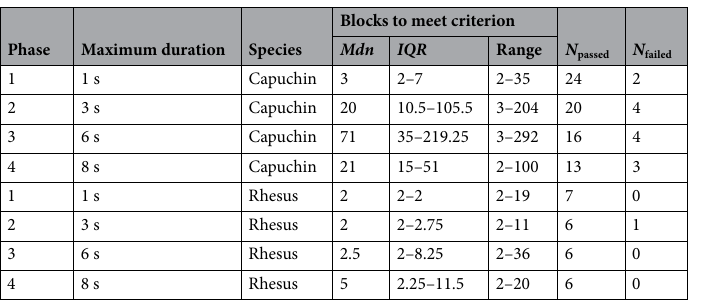
Table 1. Training phases. Maximum tracking duration required and monkeys’ training performance (number of blocks required to meet criterion and number of monkeys who did and did not meet the criterion) for each phase. Mdn Median, IQR Interquartile range.